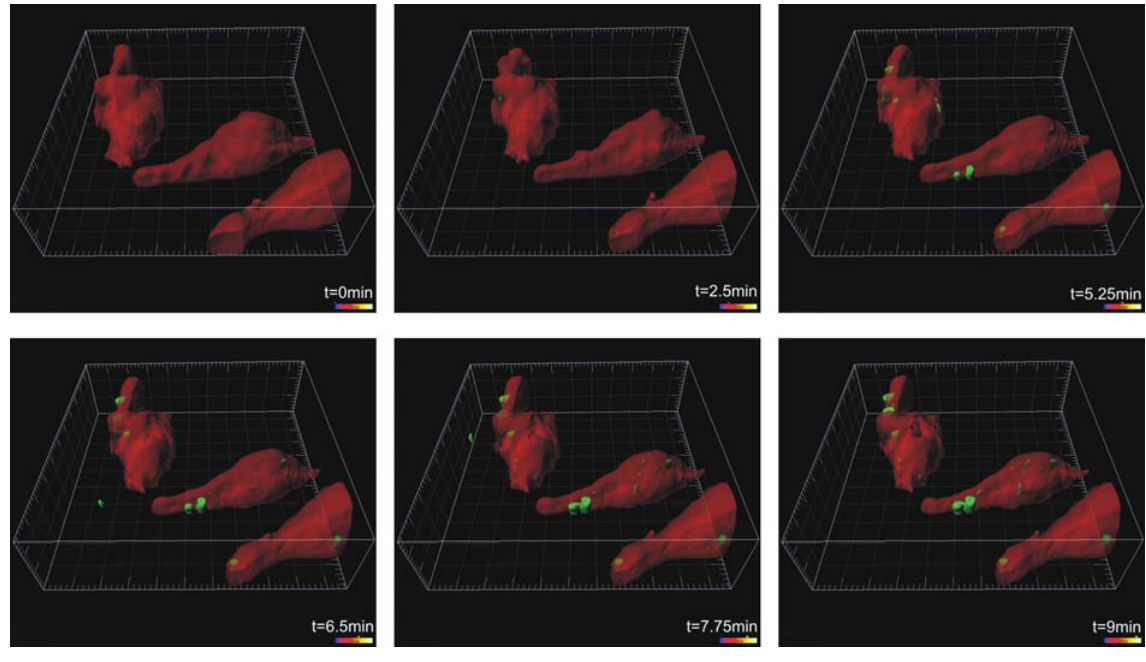
Uptake of polystyrene particles by MDM . MDM was pre-labelled with Cell tracker orange (red, transparent volume rendering). Fluorescently labelled polystyrene particles (1 μ m, green, surface rendering) were added at time point zero to the cultures and visualized for 10 minutes using a Zeiss Duo5 laser scanning microscope with the line scan modus at a z-interval of 0.3 μ m. The data restoration was done with IMARIS from Bitplane